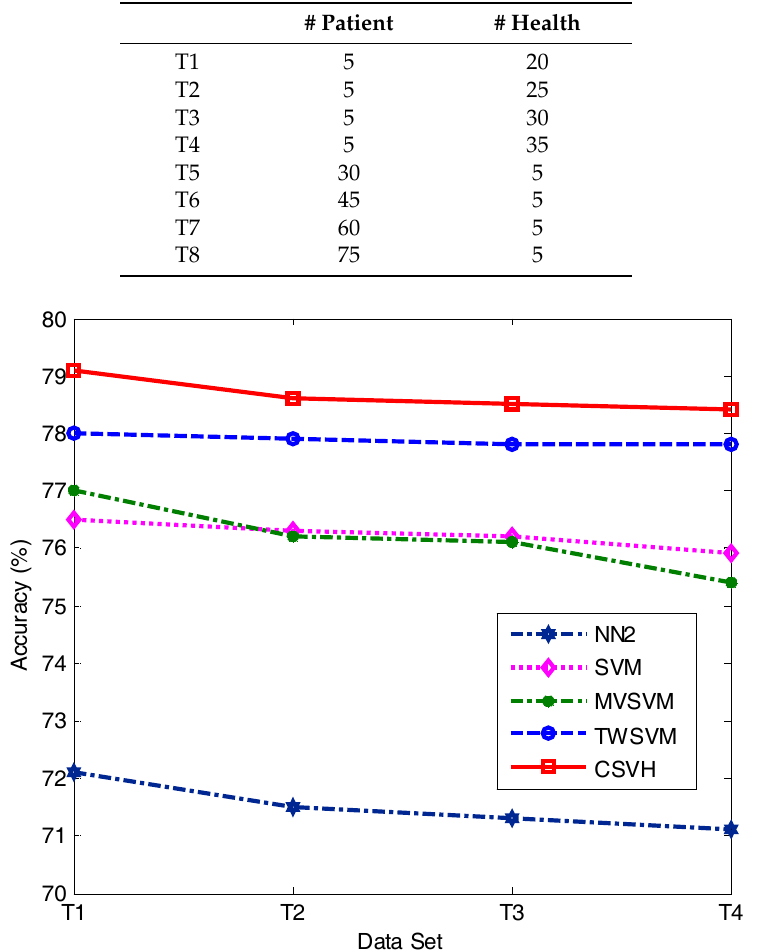
Table 6. Imbalanced training dataset details.